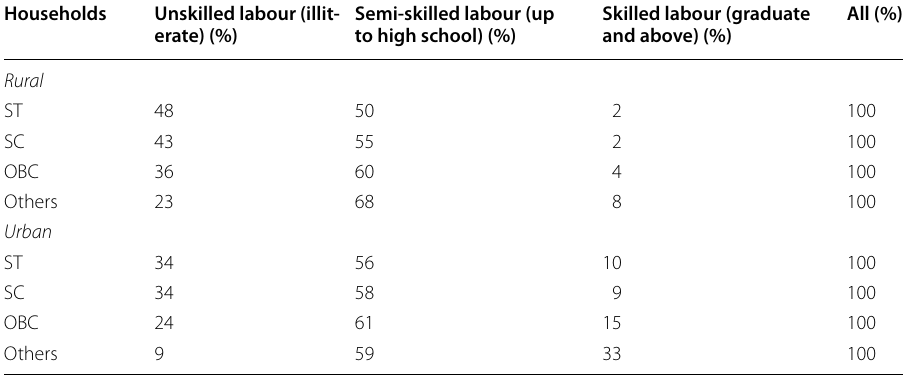
SS) across various types of skills. +